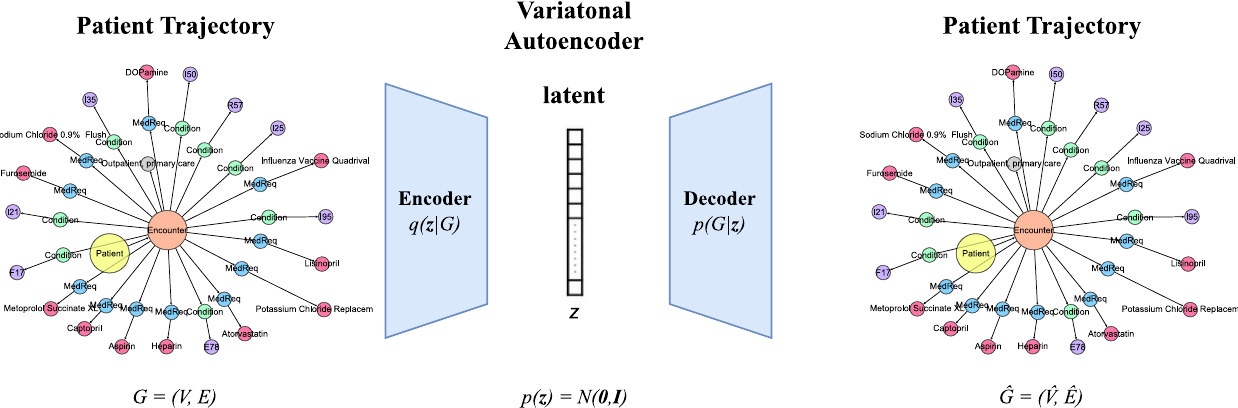
Fig. 12 An overview of the proposed variational autoencoder. To train the model, a patient trajectory is fed to the encoder, which projects the trajectory to a distribution parameterized as a multivariate Gaussian. Then a latent vector z is sampled from that distribution and is passed on to the decoder, which reconstructs the input trajectory. To generate a synthetic sample, a vector is sampled from the normal distribution and is then fed directly to the decoder, which constructs the synthetic